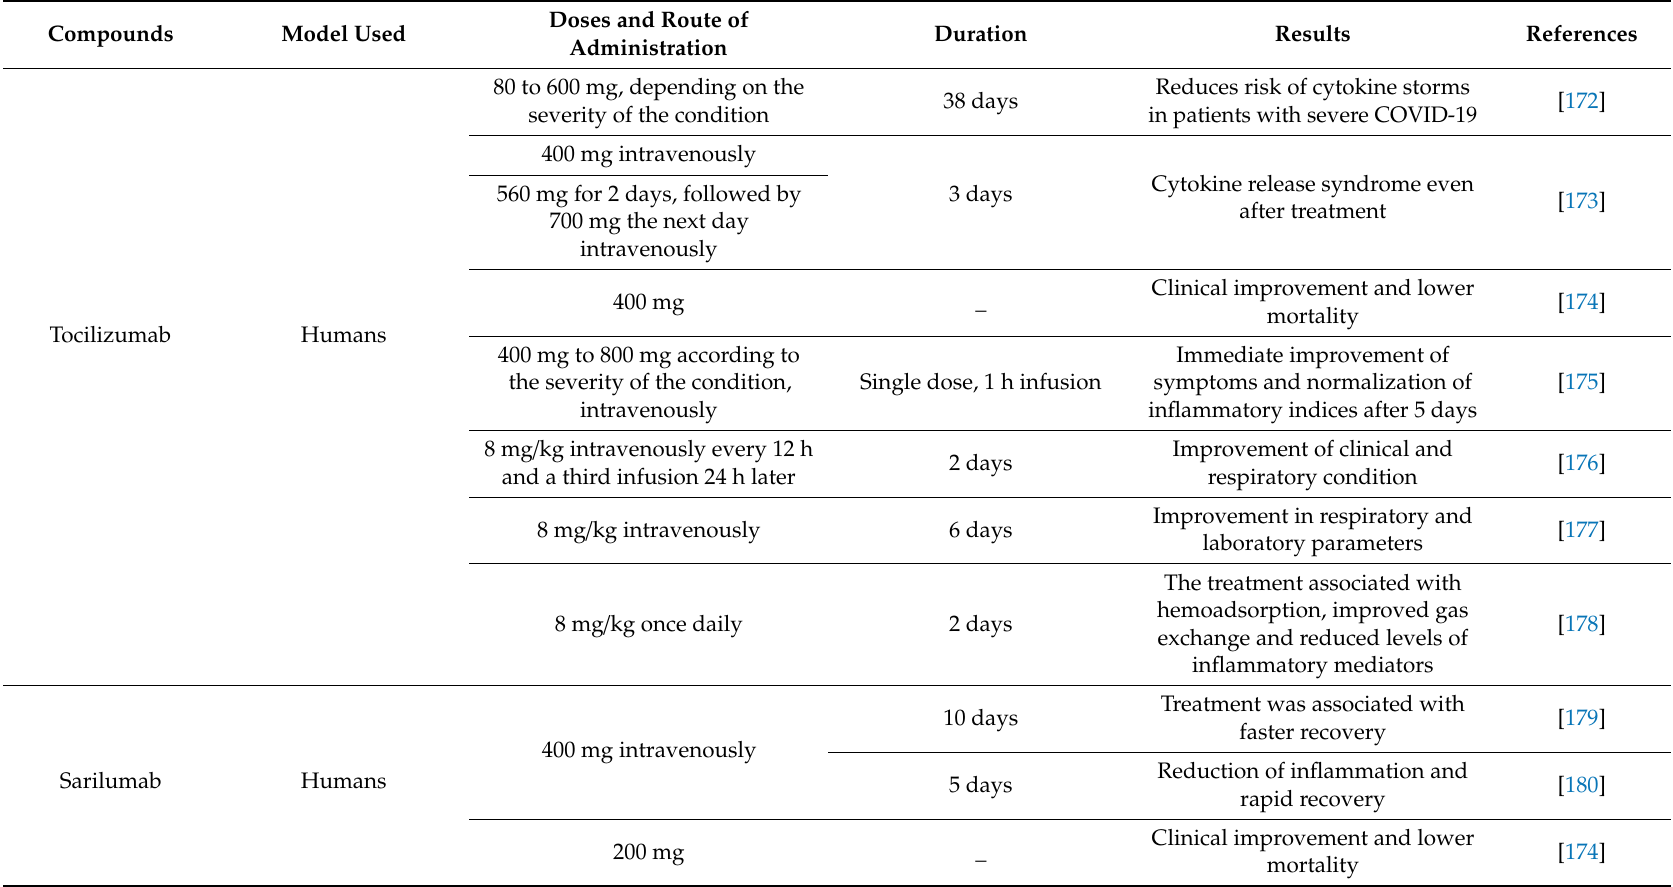
Table 3. Anti-cytokine compounds with anti-SARS-CoV-2